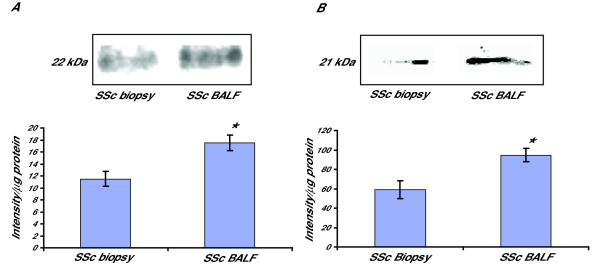
Expression of RhoA and Rac1 in fibroblasts from BALF and bronchial biopsies from patients with SSc and mild asthma. Fibroblasts were harvested in lysis buffer as described in the Method section. Equal amounts of protein were loaded on 4–12% Bis-Tris gels. Western Blotting was performed to study the expression of RhoA (A) and Rac1 (B) where the optical density of the bands was measured to determine the expression. Values are presented as means ± SEM for n = 5 patients/group. *Significant difference when comparing the expression of RhoA and Rac1 between BALF fibroblasts and biopsy fibroblasts from patients withSSc.